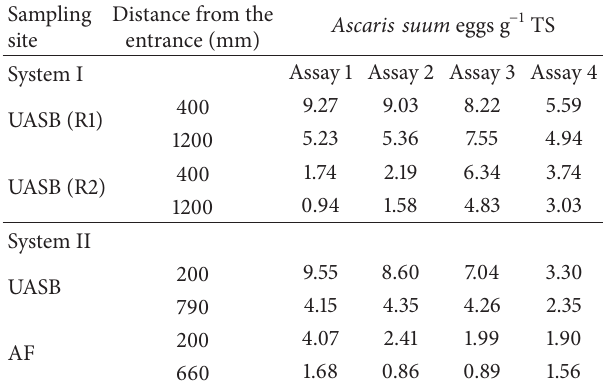
Table 8: Results of the average numbers of Ascaris suum eggs g −1 TS in the sludge of UASB reactors placed in series, at pilot scale, of treatment system I and of the UASB reactor, upflow anaerobic filter (AF) placed in series, at pilot scale, of treatment system II, in assays 1, 2, 3, and